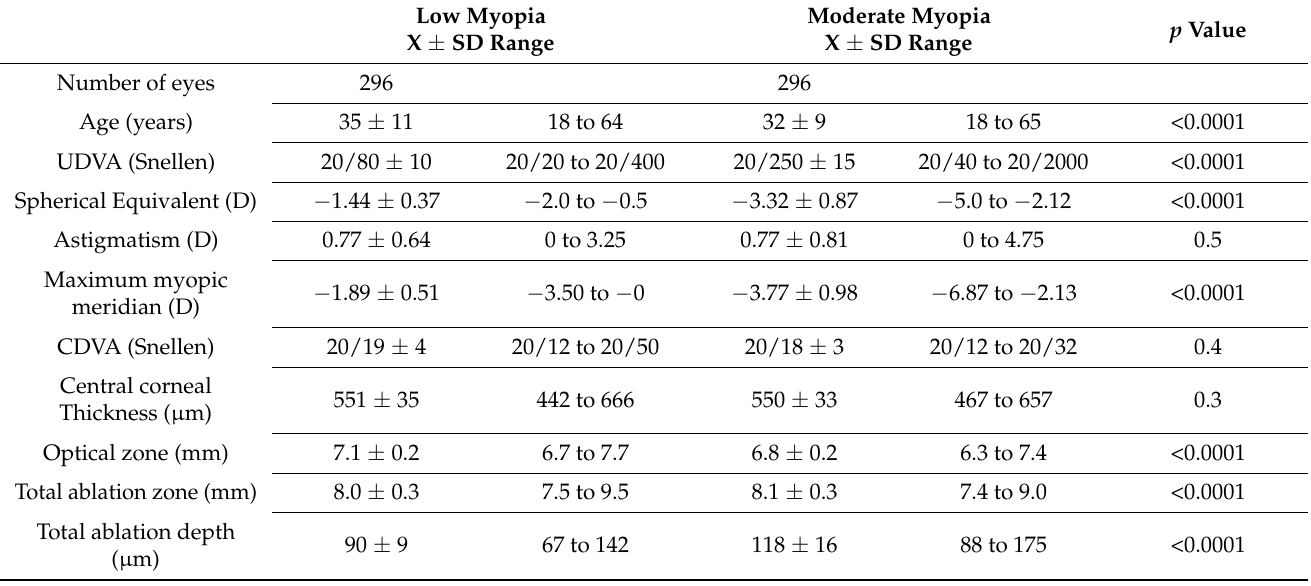
Table 1. Demographic data of the two